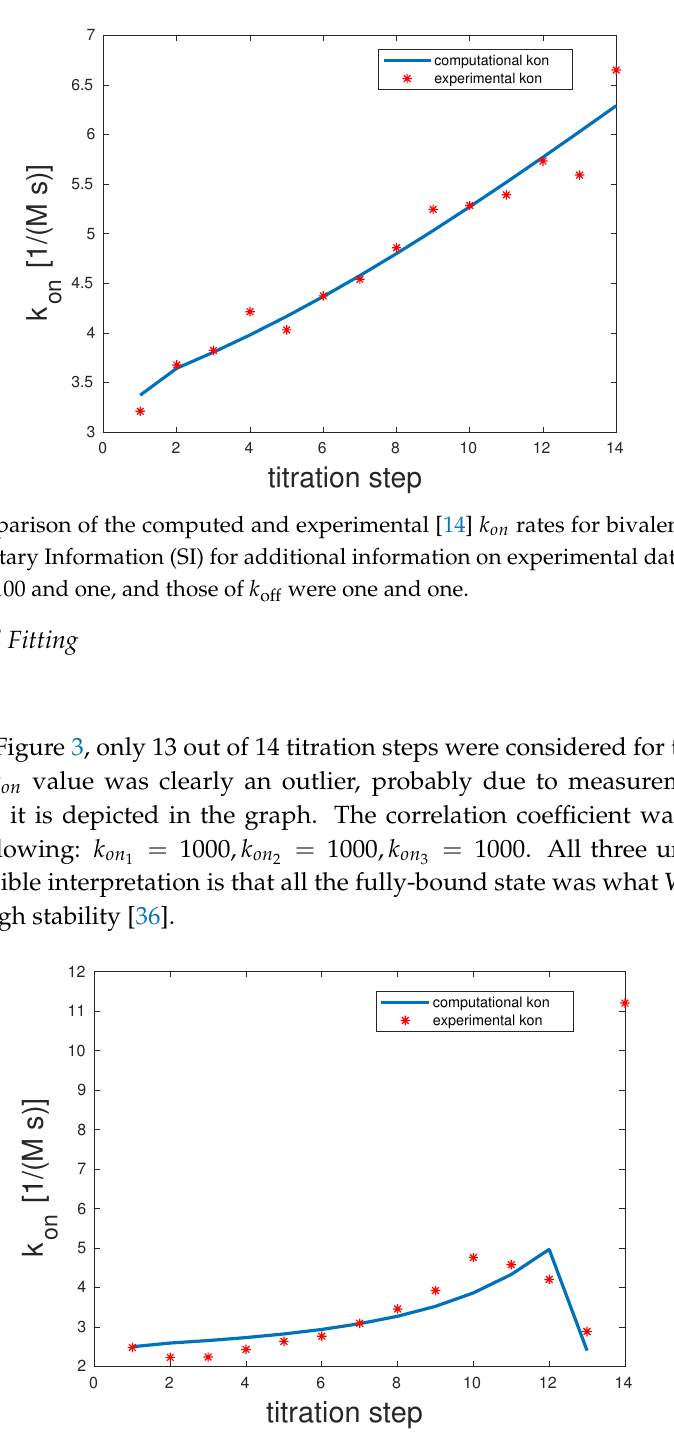
Figure 3. Comparison of the computed and experimental [14] k on rates for bivalent Man(1,3,5)-5. The k on rates were 1000, 1000, and 1000 and for k off were 1, 1, and